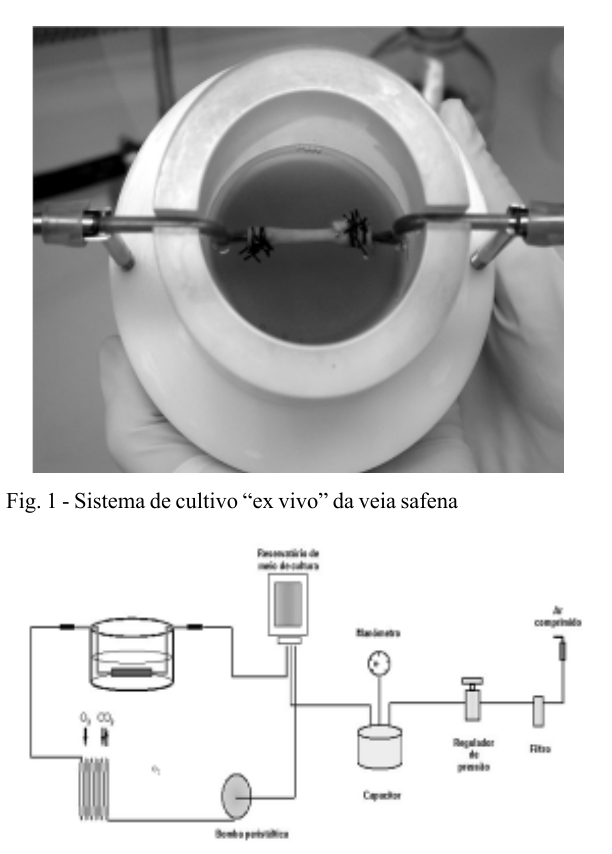
Fig. 2 - Representação esquemática do sistema de cultura “ex vivo”, que permite o controle de pressão e de fluxo pela veia